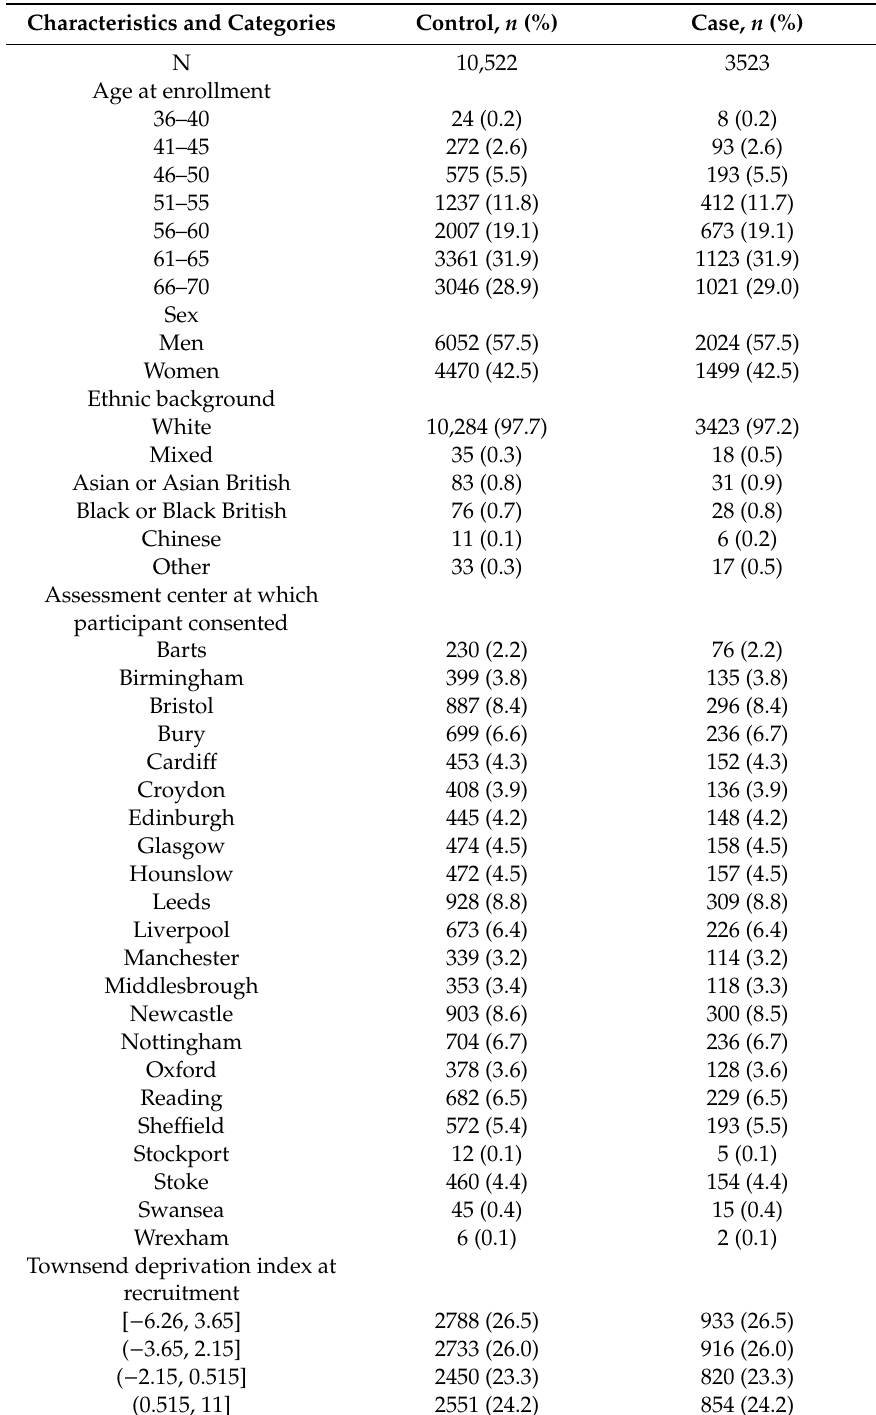
Table 2. The number of controls and patients with colorectal cancer in a nested case-control study from the participants in the UK